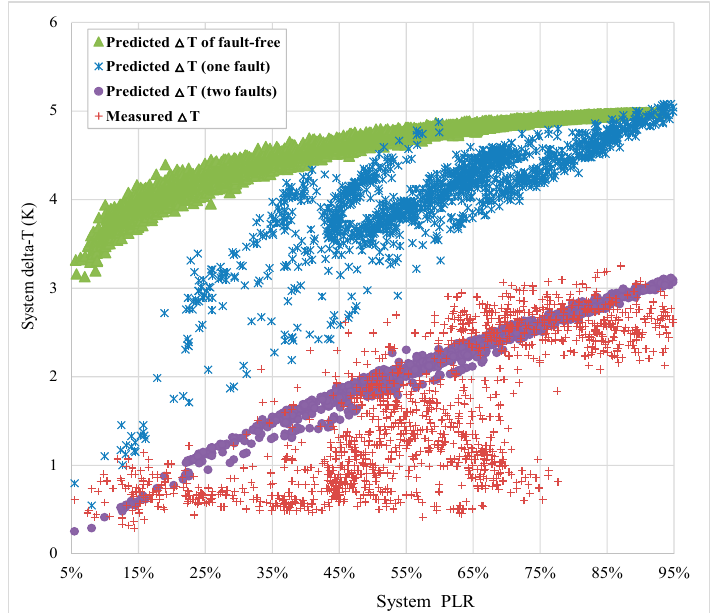
Figure 6. Predicted and measured system delta-T under part load conditions.